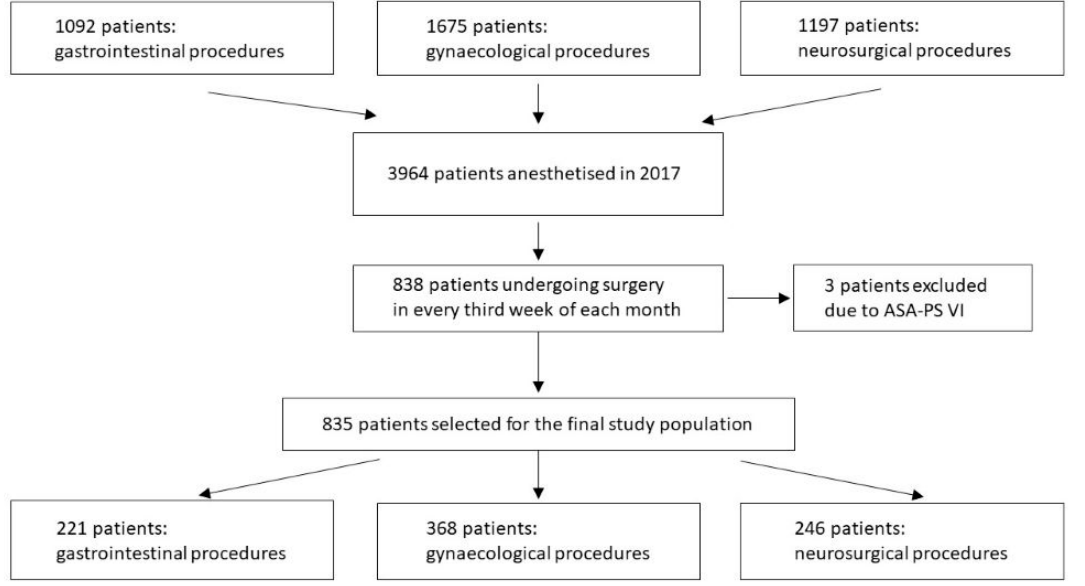
Figure 1. Flowchart of the study population.